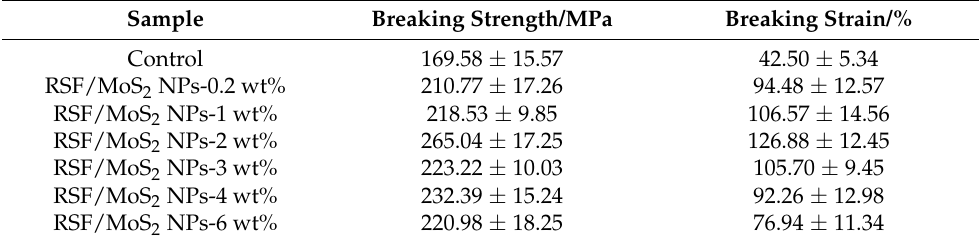
Table 3. The mechanical properties of RSF/MoS 2 NPs hybrid